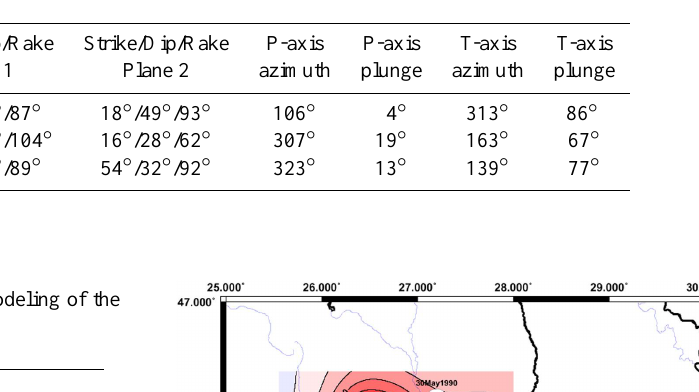
Table 2. Principal stress axes as calculated using the RAKE software (Louvari and Kiratzi, 1997). Slip models are after Tavera (1991) and the global CMT project.